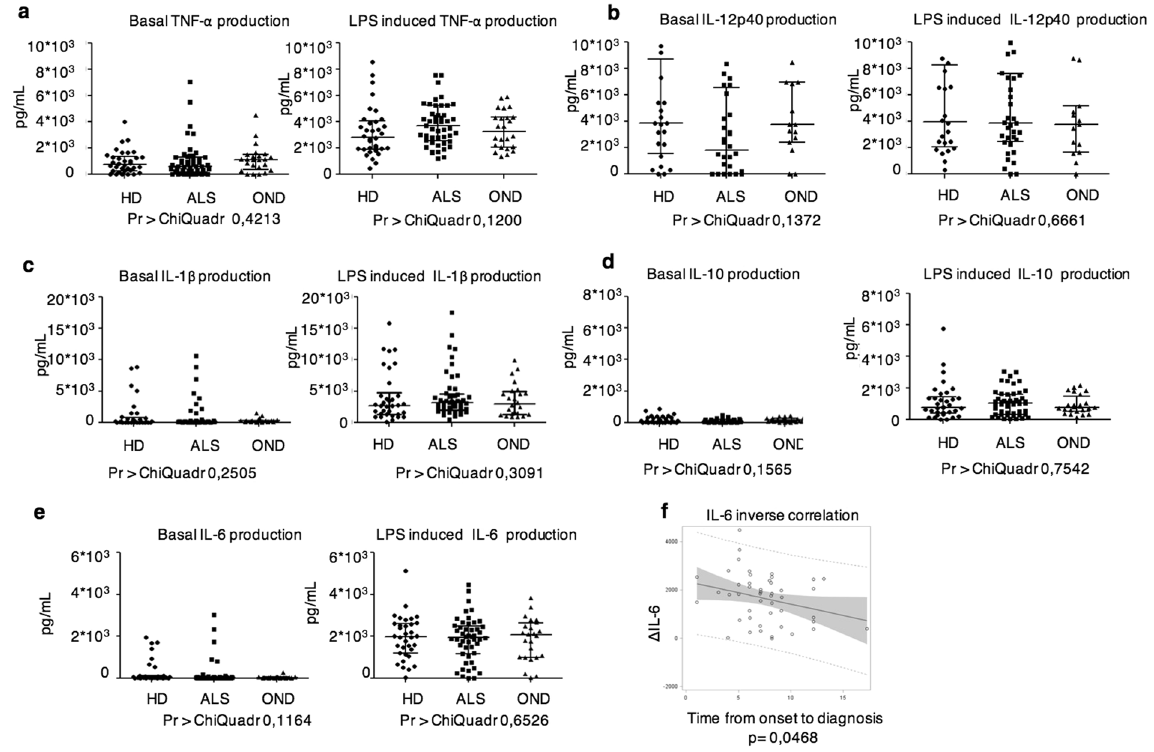
Figure 3. Amounts of spontaneous or LPS-induced cytokine production by DCs purified from peripheral blood of ALS patients (n = 52), HD (n = 36) or OND (n = 25). ( a – e ) Scatter plots of the amounts of the indicated cytokines produced by DCs from ALS, HD and ODN 24 h after in vitro culture in the presence or absence of LPS. ( f ) IL-6 and Time from Onset to Diagnosis correlation. An inverse correlation (p = 0,048 - Spearman test) between the time from onset to diagnosis and the Δ IL-6 levels (IL-6 LPS – IL-6 NT) is